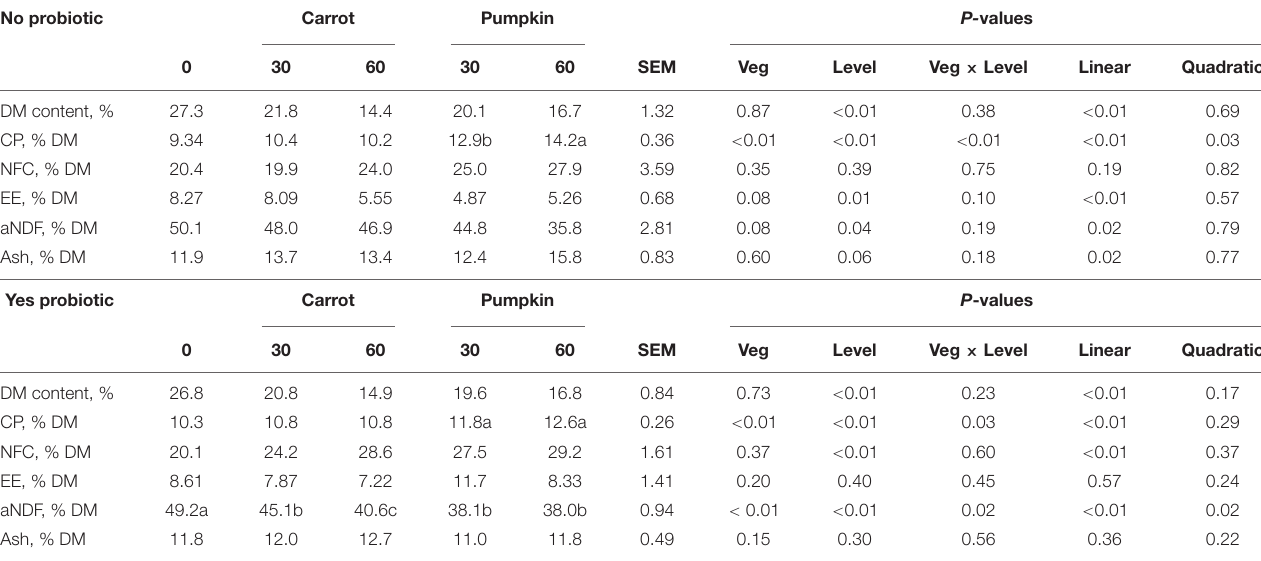
TABLE 1 | Chemical composition of silages with carrot or pumpkin at 0, 30, or 60% DM, with (yes) or without (no) a probiotic inoculant. No